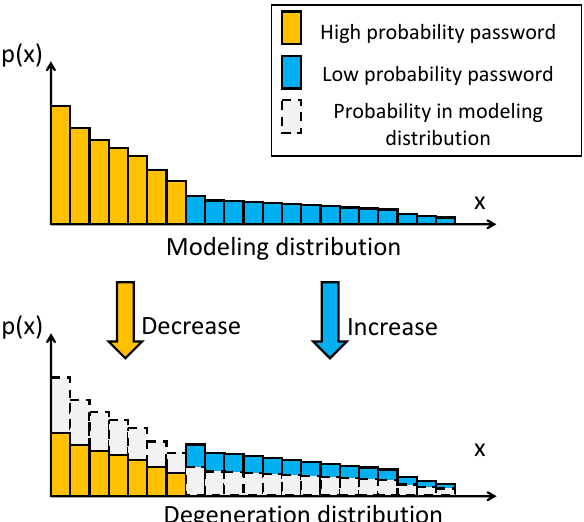
Figure 2. Evolution relationship between modeling distribution and degeneration distribution.